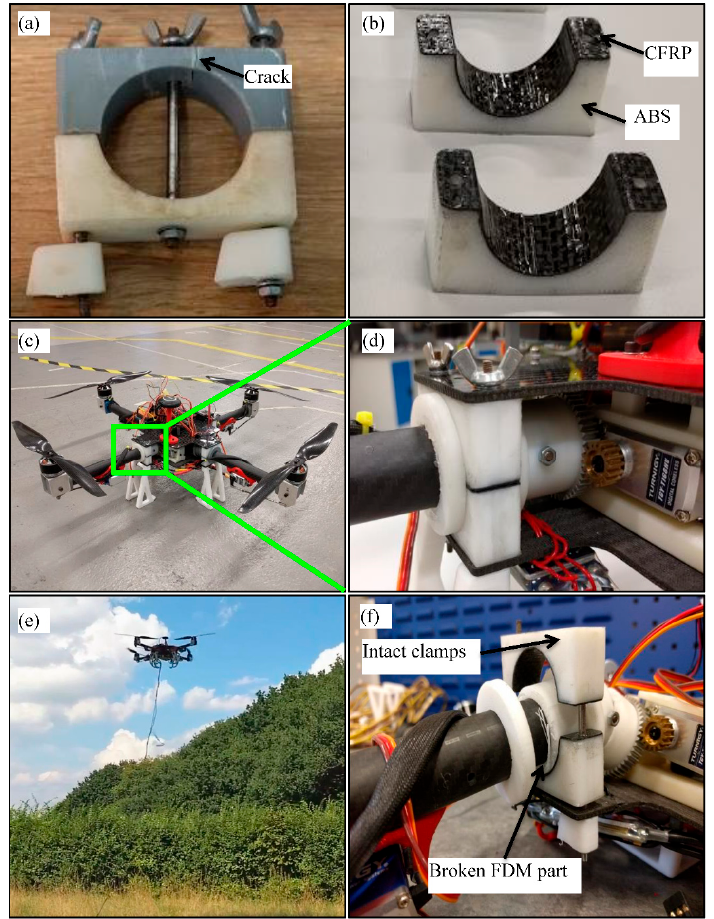
Figure 11. ( a ) Original monolithic clamp; ( b ) CFRP/ABS composite clamps; ( c ) Assembled quadcopter; ( d ) magnified photo of the assembled clamp; ( e ) quadcopter during flights test; ( f ) CFRP/ABS composite clamp after a crash test.